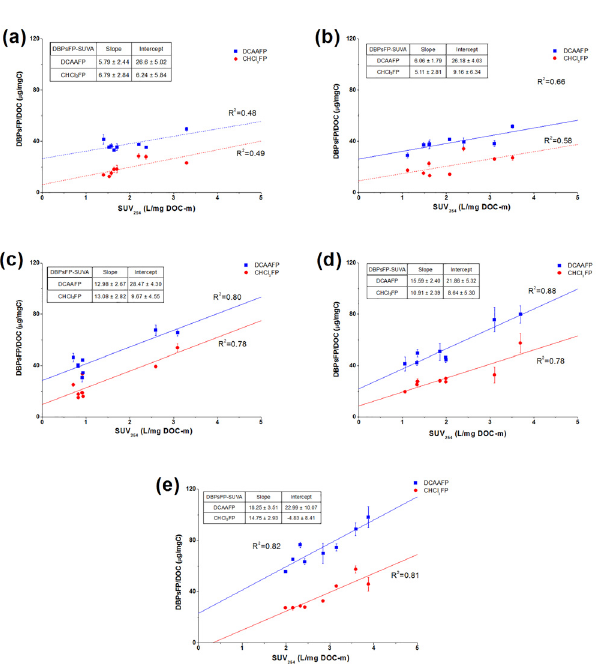
Fig 2. Correlations of DCAAFP and CHCl 3 FP yields with SUVA values in the raw and coagulated waters. (a) > 100k Da fraction; (b) 30-100k Da fraction; (c) 10-30k Da fraction; (d) 3-10k Da fraction; (c) < 3k Da